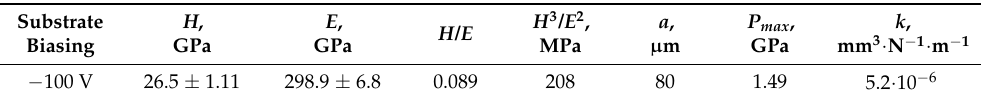
Table 4. Mechanical and tribological properties of the Ti 0.61 Al 0.39 N coating deposited by the Al magnetron at 1 kW of